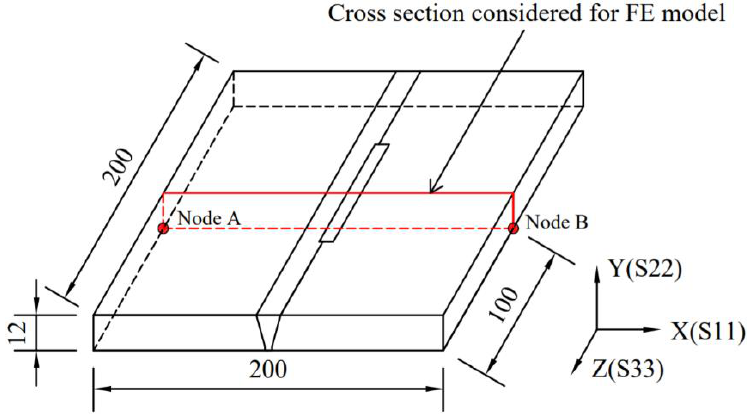
Figure 4. The location of the cross section for analysis. (unit: mm).